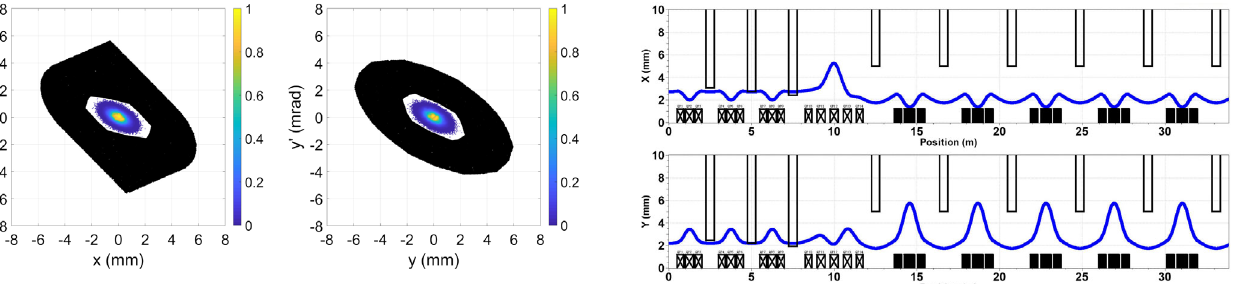
FIG. 12. 5 σ envelope in optimized collimation and VDS section for 1.5 GeV beam.